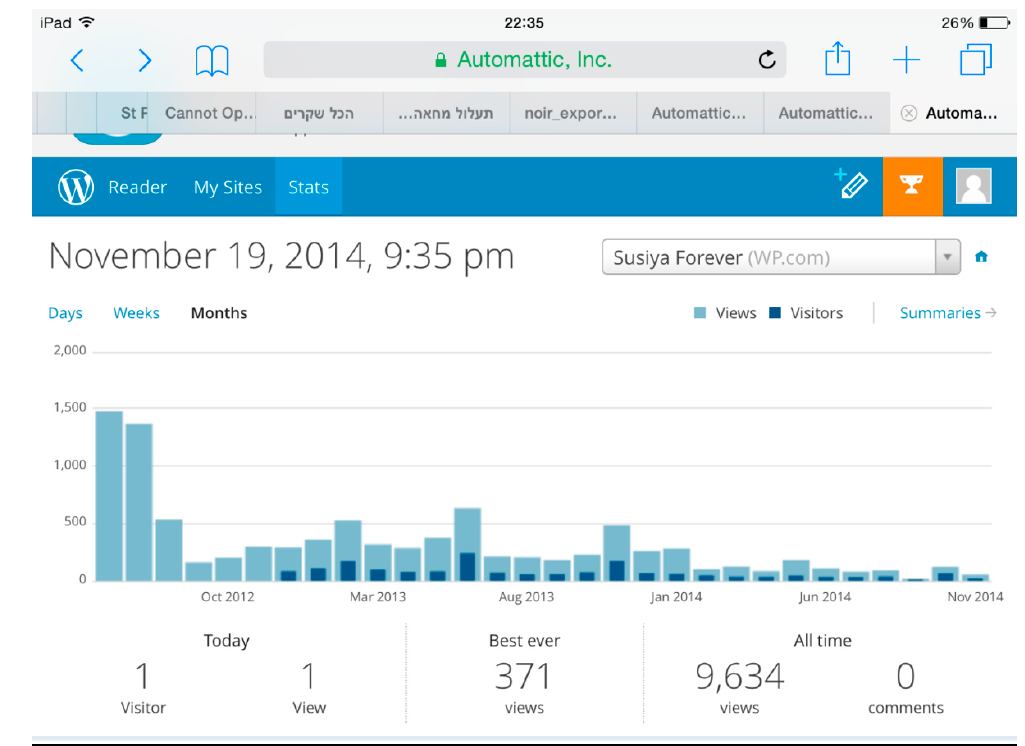
Figure 7. Screen Grab of WordPress visitor traffic to the Susiya Forever blog. Source: Webmaster for The Village Group.